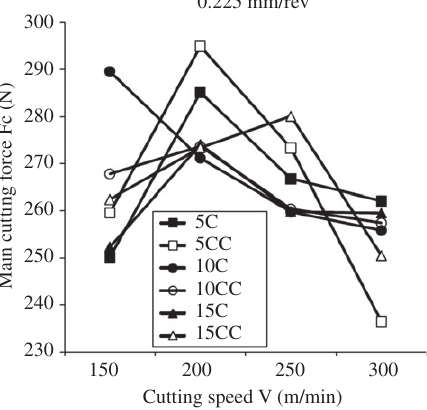
Figure 6 Changes in Fc values in 5%, 10% and 15% MgO reinforced MMC specimens by cutting speed (C and CC cutting tools; 0.075 mm/rpm feed rate). (KISTLER 9257B type dynamometer, Kistler Dynoware Software, Switzerland).